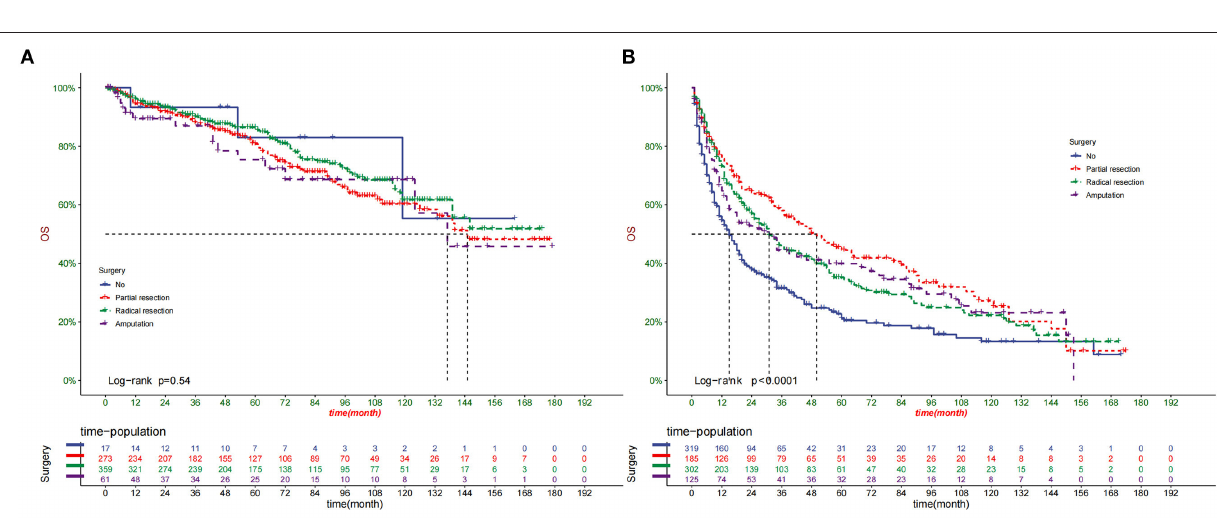
FIGURE 7 | Comparison of different surgical methods of Kaplan–Meier curves in low-risk (A) and high-risk (B)